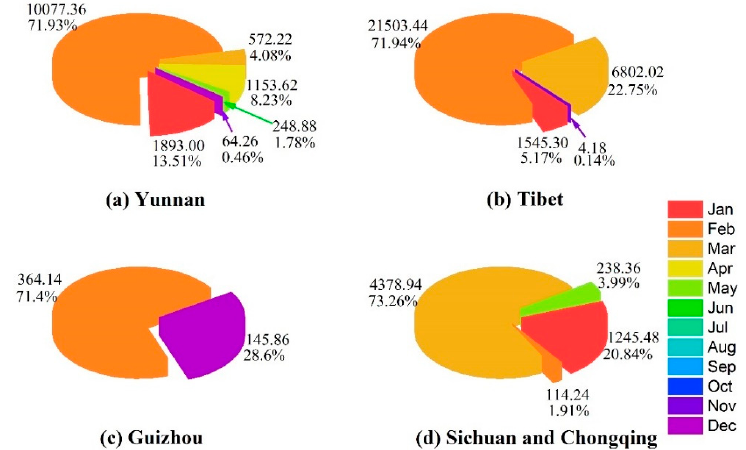
Figure 4. The monthly CO emissions of the provinces in southwest China in 2017 (units: Mg). ( a ) CO emissions in Yunnan, ( b ) CO emissions in Tibet, ( c ) CO emissions in Guizhou, ( d ) CO emissions in Sichuan and Chongqing.